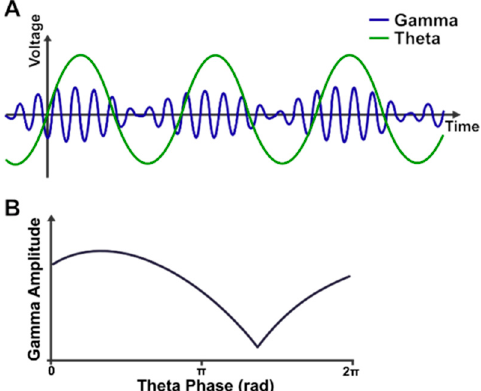
Figure 1. Schematic illustration of theta-gamma phase-amplitude coupling ( A ), with the gamma amplitude being modulated by the theta phase. ( B ) shows the average gamma amplitude (i.e., the average envelope amplitude) at different theta phases. Note that the peak